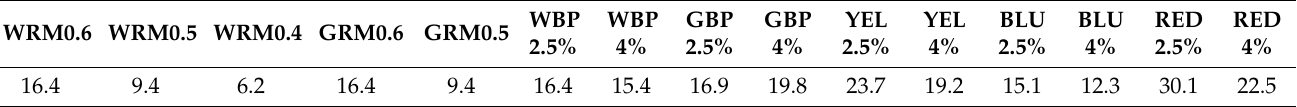
Table 6. Values of the diffusion coefficient in non-stationary regime, D 0 × 10 − 12 (m 2 /s).